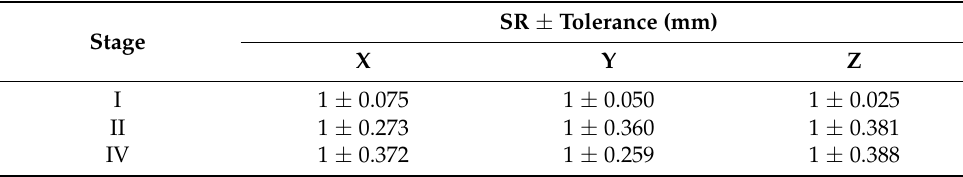
Figure 8. Resolution test sample ( a ) Desired path and ( b ) experimentation result. Table 4. System resolution.